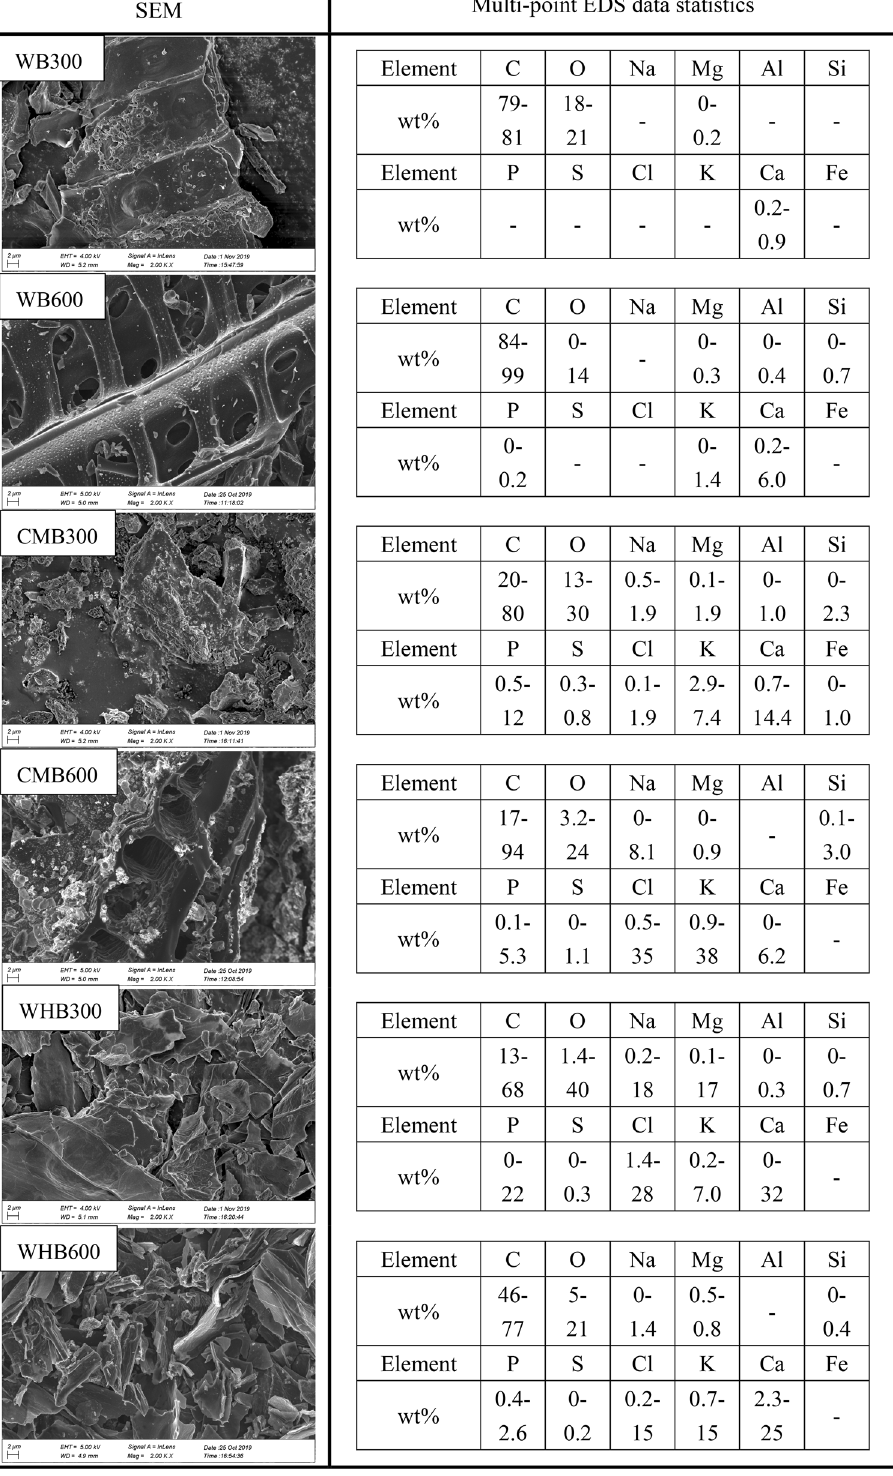
Figure 2. SEM and EDS analysis for produced biochar